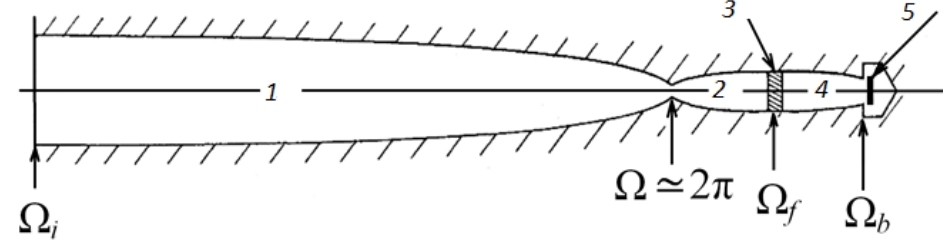
Figure 7. Construction of integrating cavity (reprinted with permission from ref. [10], Figure 4, yright 1978 The Optical Society): (1) Winston concentrator determining throughput A Ω ; (2) second Copyright 1978 The Optical Society): (1) Winston concentrator determining throughput A Ω ; concentrator; (3) bandpass filter; (4) third cone; (5) directly irradiating bolometer in third cavity. (2) second concentrator; (3) bandpass filter; (4) third cone; (5) directly irradiating bolometer in third